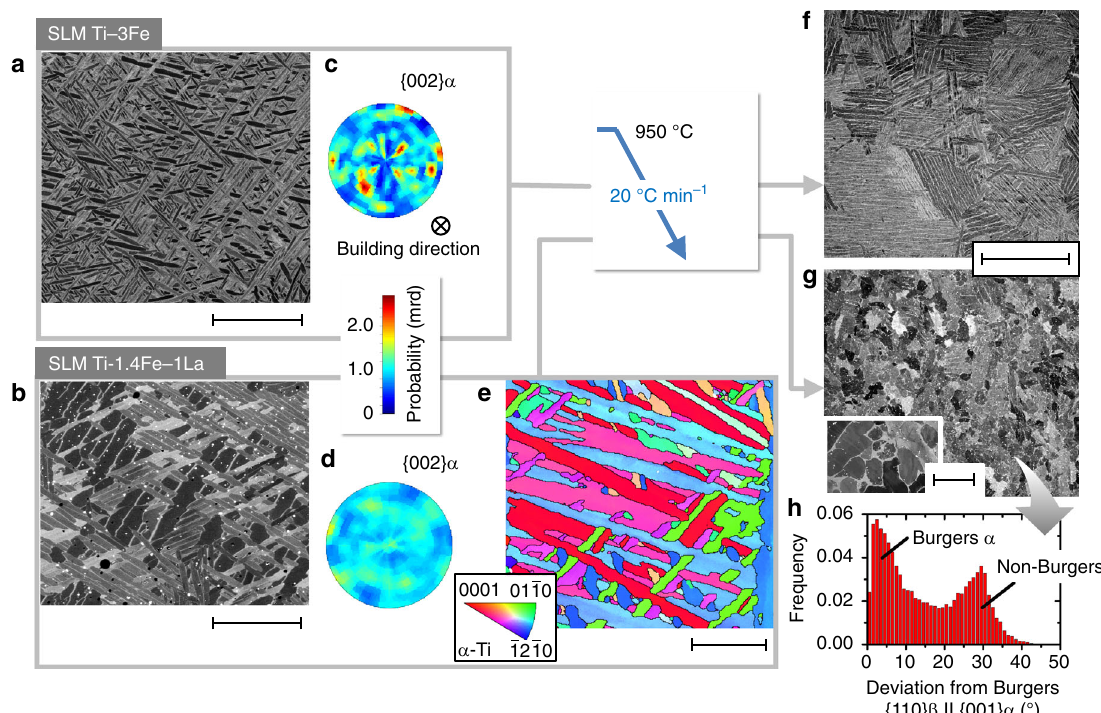
Fig. 5 Reducing solidi fi cation texture during additive manufacturing of titanium alloys. Formation of fi ne α particles with multiple orientations occurs within colonies of α lamellae by addition of the peritectic forming solute La. a , b Transformation of α during selective laser melting (SLM) of Ti-3wt.% Fe (Ti-3Fe) and Ti-1.4Fe-1La (wt.%), respectively (scale bars, 10 μ m). For the fi rst case, α forms directly from parent β grains: the typical path of β → α transformation that results in a lamellar α + β microstructure. For the second, an additional path of α formation not linked with the orientation relationship of the parent β phase takes place. This is re fl ected in c , d : normalized pole fi gures of {002} α reconstructed from a gauge volume of 1 × 1 × 5 mm 3 for Ti-3Fe and Ti-1.4Fe- 1La, respectively. e α particles of diverse orientations that can reach diameters <1 μ m form at boundaries of α lamellae during SLM of Ti-1.4Fe-1La. Black lines indicate high angle grain boundaries (misorientation >10°). Scale bar, 5 μ m. f , g Post thermal treatment by slow cooling the Ti-3Fe and Ti-1.4Fe-1La alloys from 950 °C with 20 °C min − 1 down to room temperature, leads on the one hand, to a typical lamellar α + β microstructure and on the other, to extensive globularization of α , respectively. Scale bars in f and g , 250 μ m; 30 μ m in the inset of g . h The two paths of α formation taking place for the heat treated Ti-1.4Fe-1La alloy are re fl ected in the bi-modal distribution obtained for lattice correlation boundaries between α and β